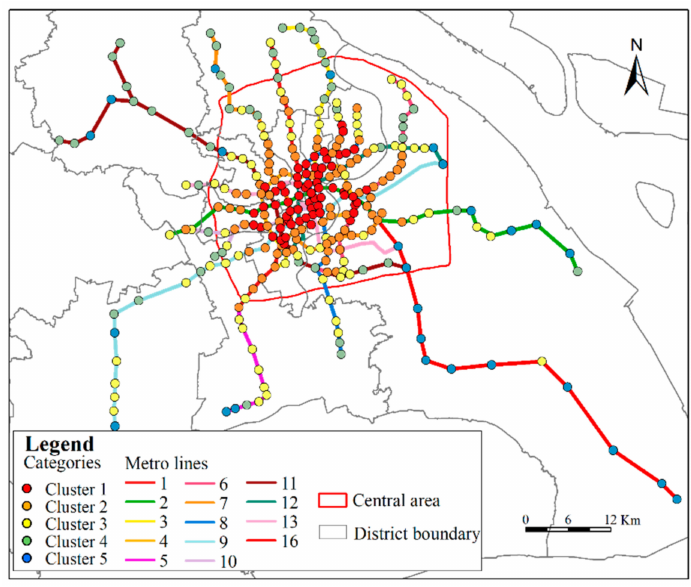
Figure 7. Results of the NP model. Table 5. Summary of the five